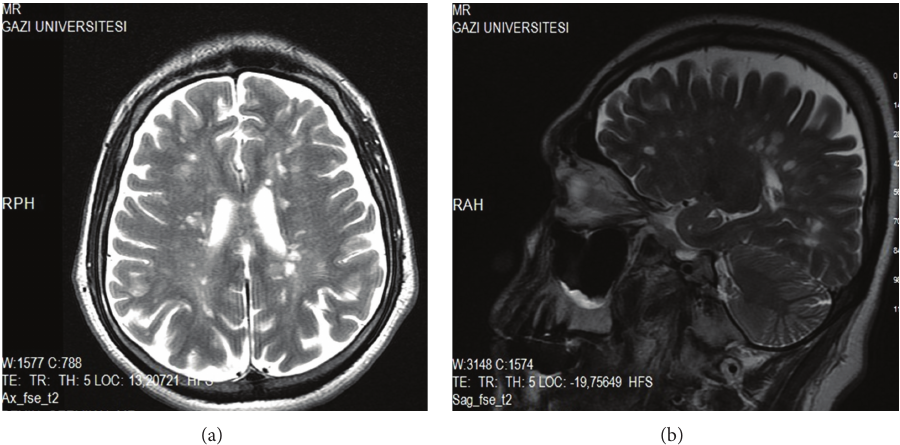
Figure 2: (a) Demyelinating periventricular lesions, T2 weighted axial section, (b) demyelinating periventricular lesions, T2 weighted sagittal section, and control brain